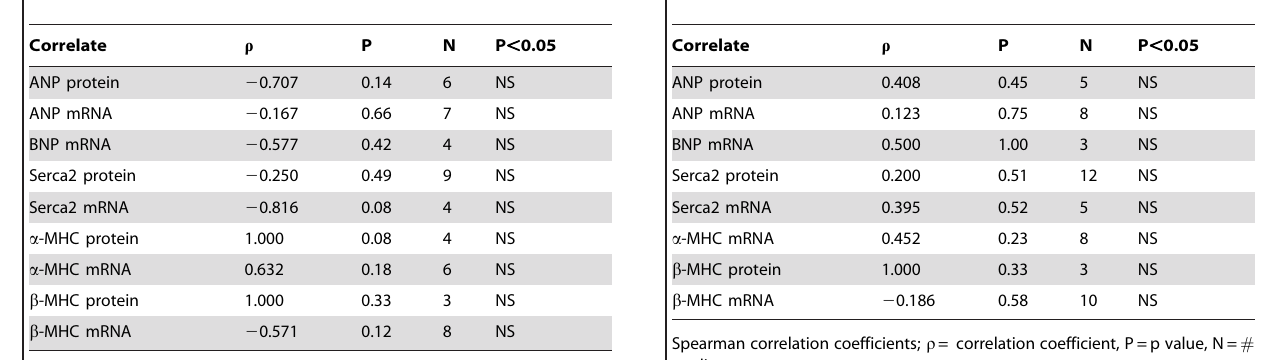
Table 9. Spearman correlations of fetal genes with absolute heart weight in rodent models of type 2 diabetes.